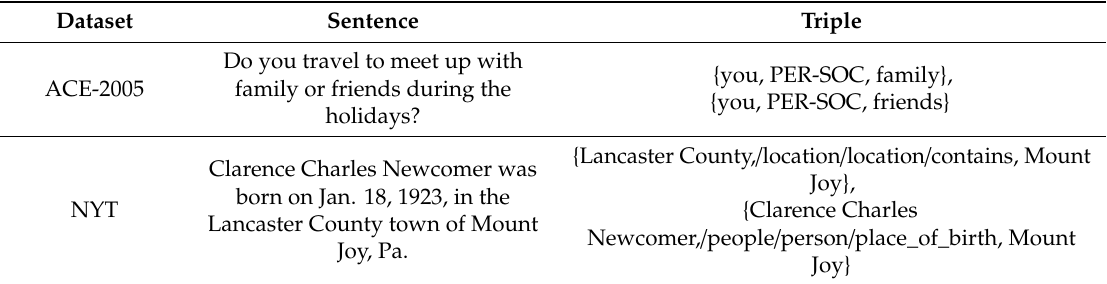
Table 3. Sample of the ACE-2005 corpus and the NYT corpus. PER-SOC: person-social. Dataset